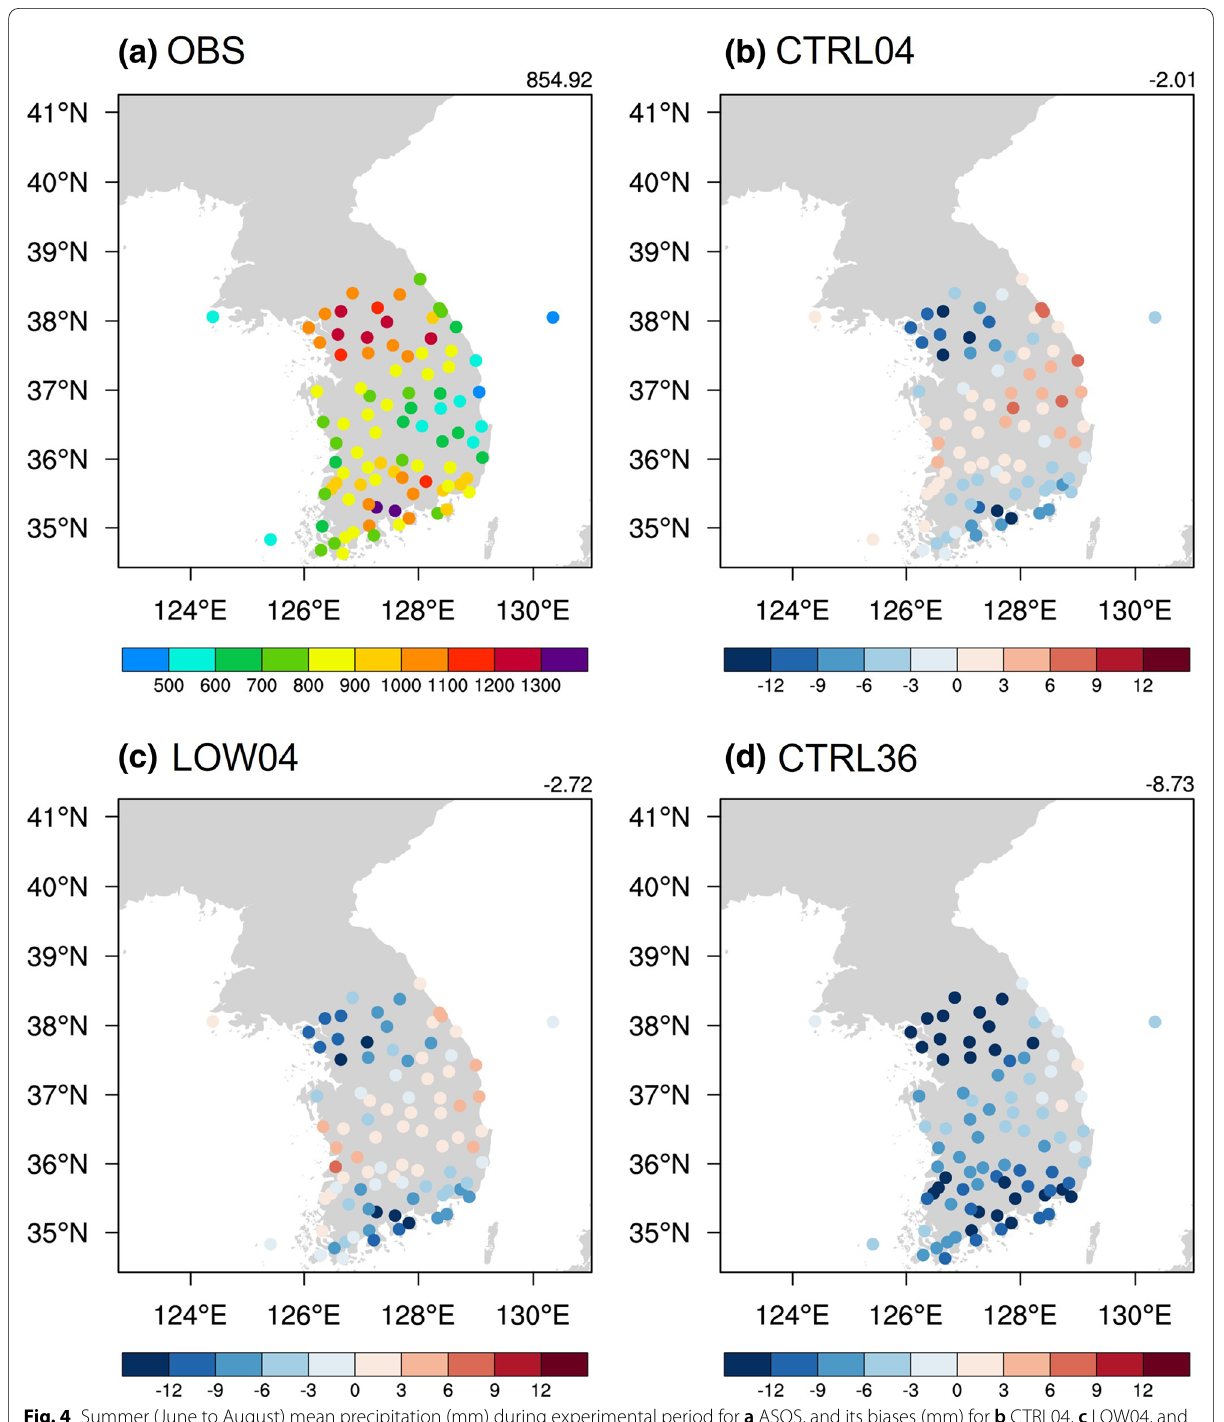
Fig. 4 Summer (June to August) mean precipitation (mm) during experimental period for a ASOS, and its biases (mm) for b CTRL04, c LOW04, and d CTRL36, respectively. The mean values of the biases are written on the top‑right of each